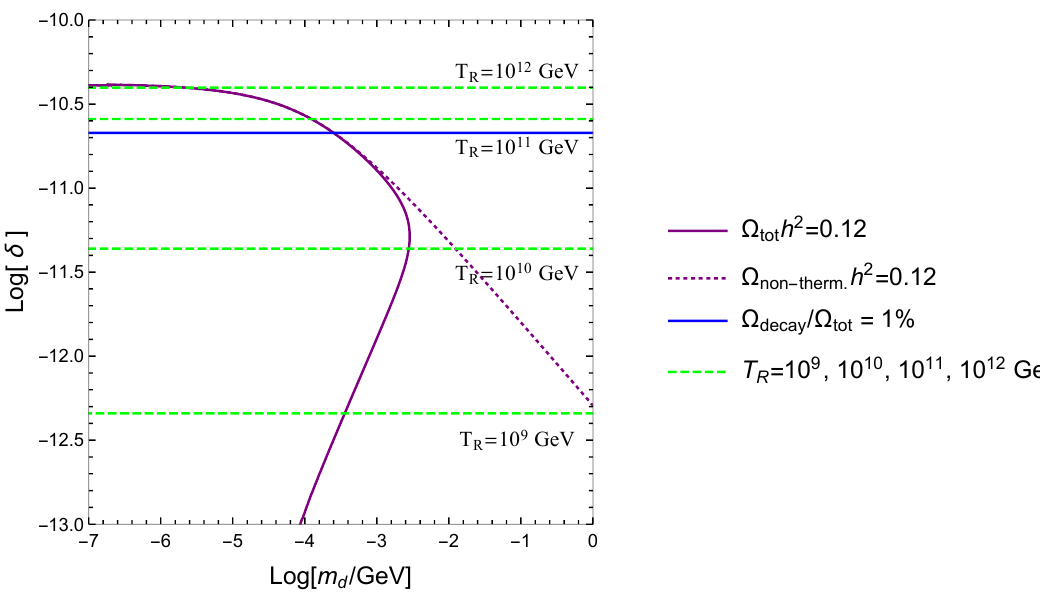
Figure 4 . Same legend as (cid:12)gure 3 for a mass m v = 10